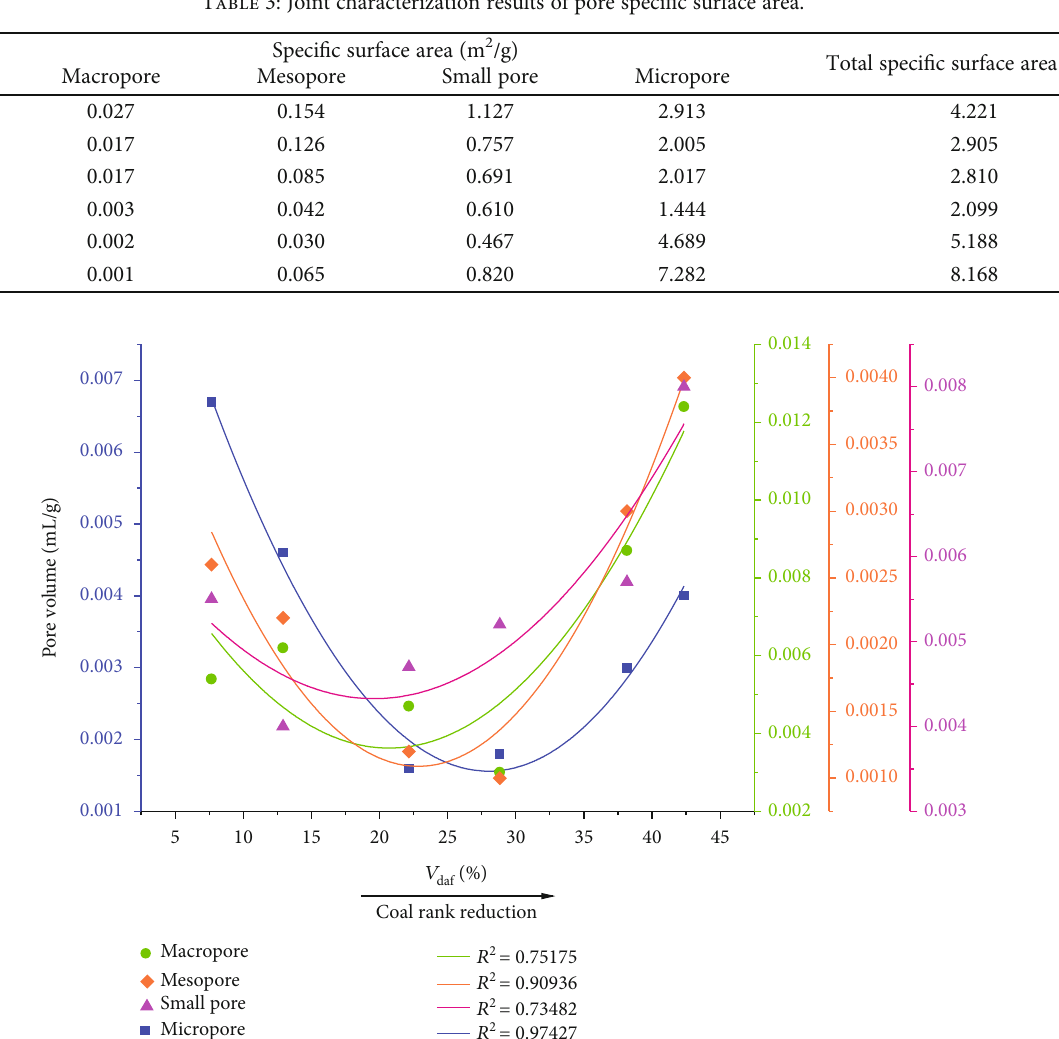
Table 3: Joint characterization results of pore speci fi c surface area.